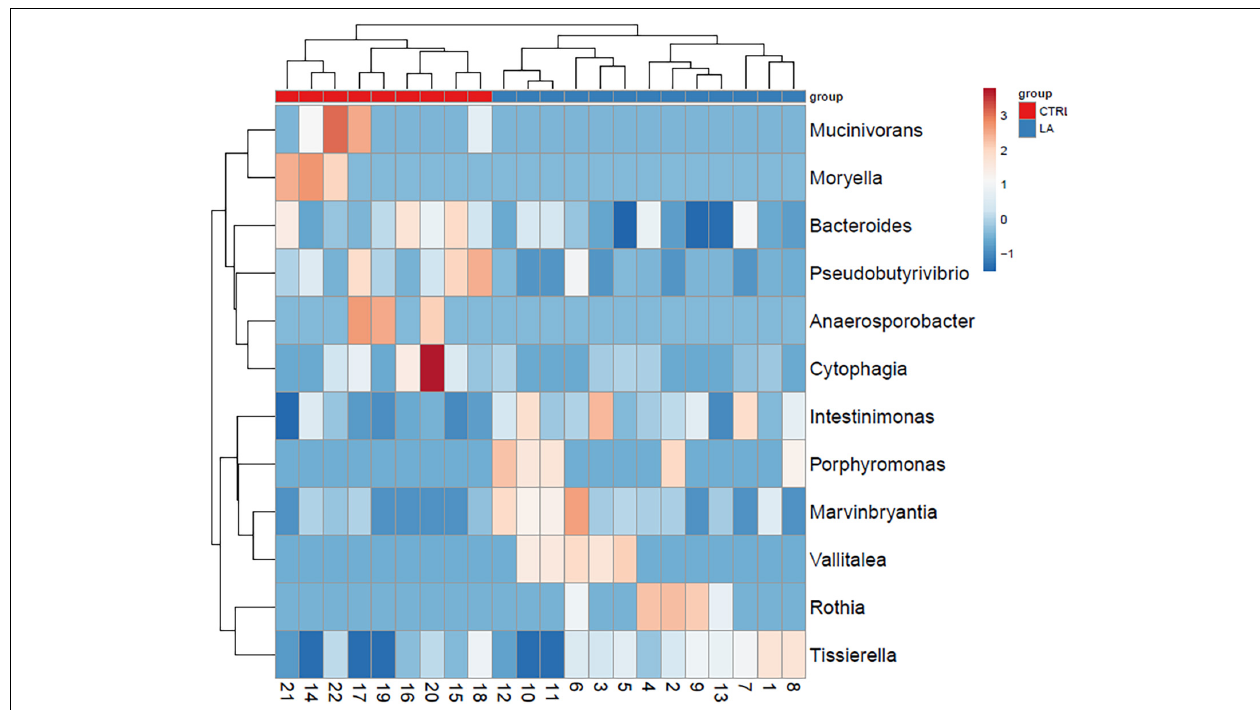
FIGURE 3 | Microbial composition of significantly ( p < 0.05) distinct bacterial genera within the healthy control group (CTRL) and elderly athletes (LA) seniors. Selected rows are centerd; unit variance scaling is applied to rows. Imputation is used for missing value estimation. Both rows and columns are clustered using correlation distance and average linkage. Numbers represent samples visualized by heat map.